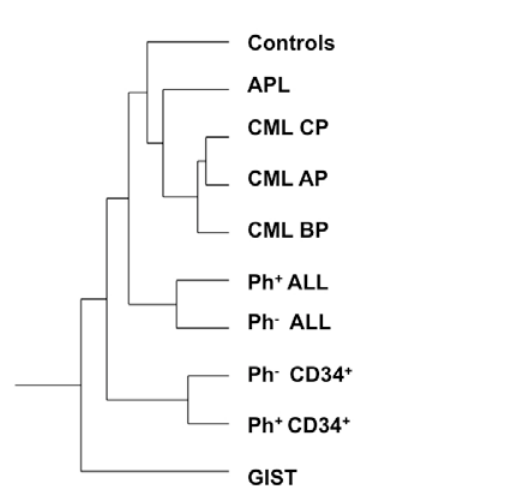
Figure 3: The hierarchical tree of leukemias with mean DNA methyla- tion. Relationship of DNA methylation profile by clustering based analysis with different leukemias, GIST, Ph +/- CD34 + hematopoietic stem cells, and healthy controls. A close relationship is demonstra- ted for the different phases of CML and myeloid leukemias (CML and APL), lymphoid leukemias (Ph + ALL and Ph - ALL) and hematopoietic stem cells (Ph +/- CD34 + ). Relationships identified by clustering are independent of BCR-ABL